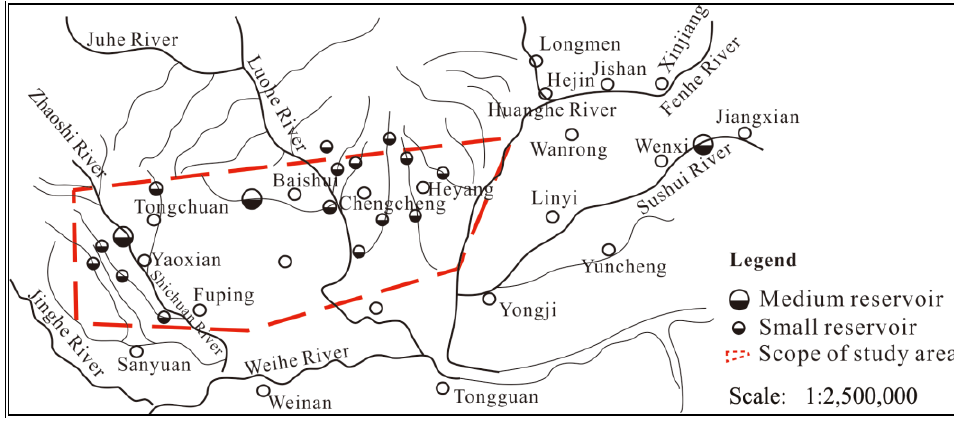
Figure 1. Scope of study